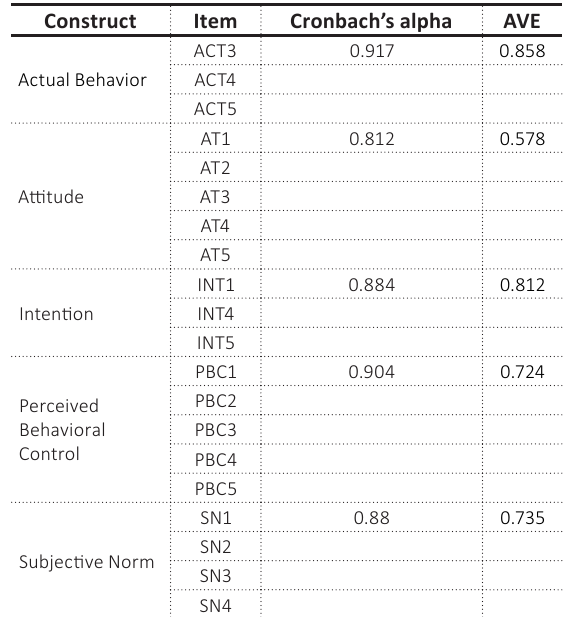
Table 1. Measurement